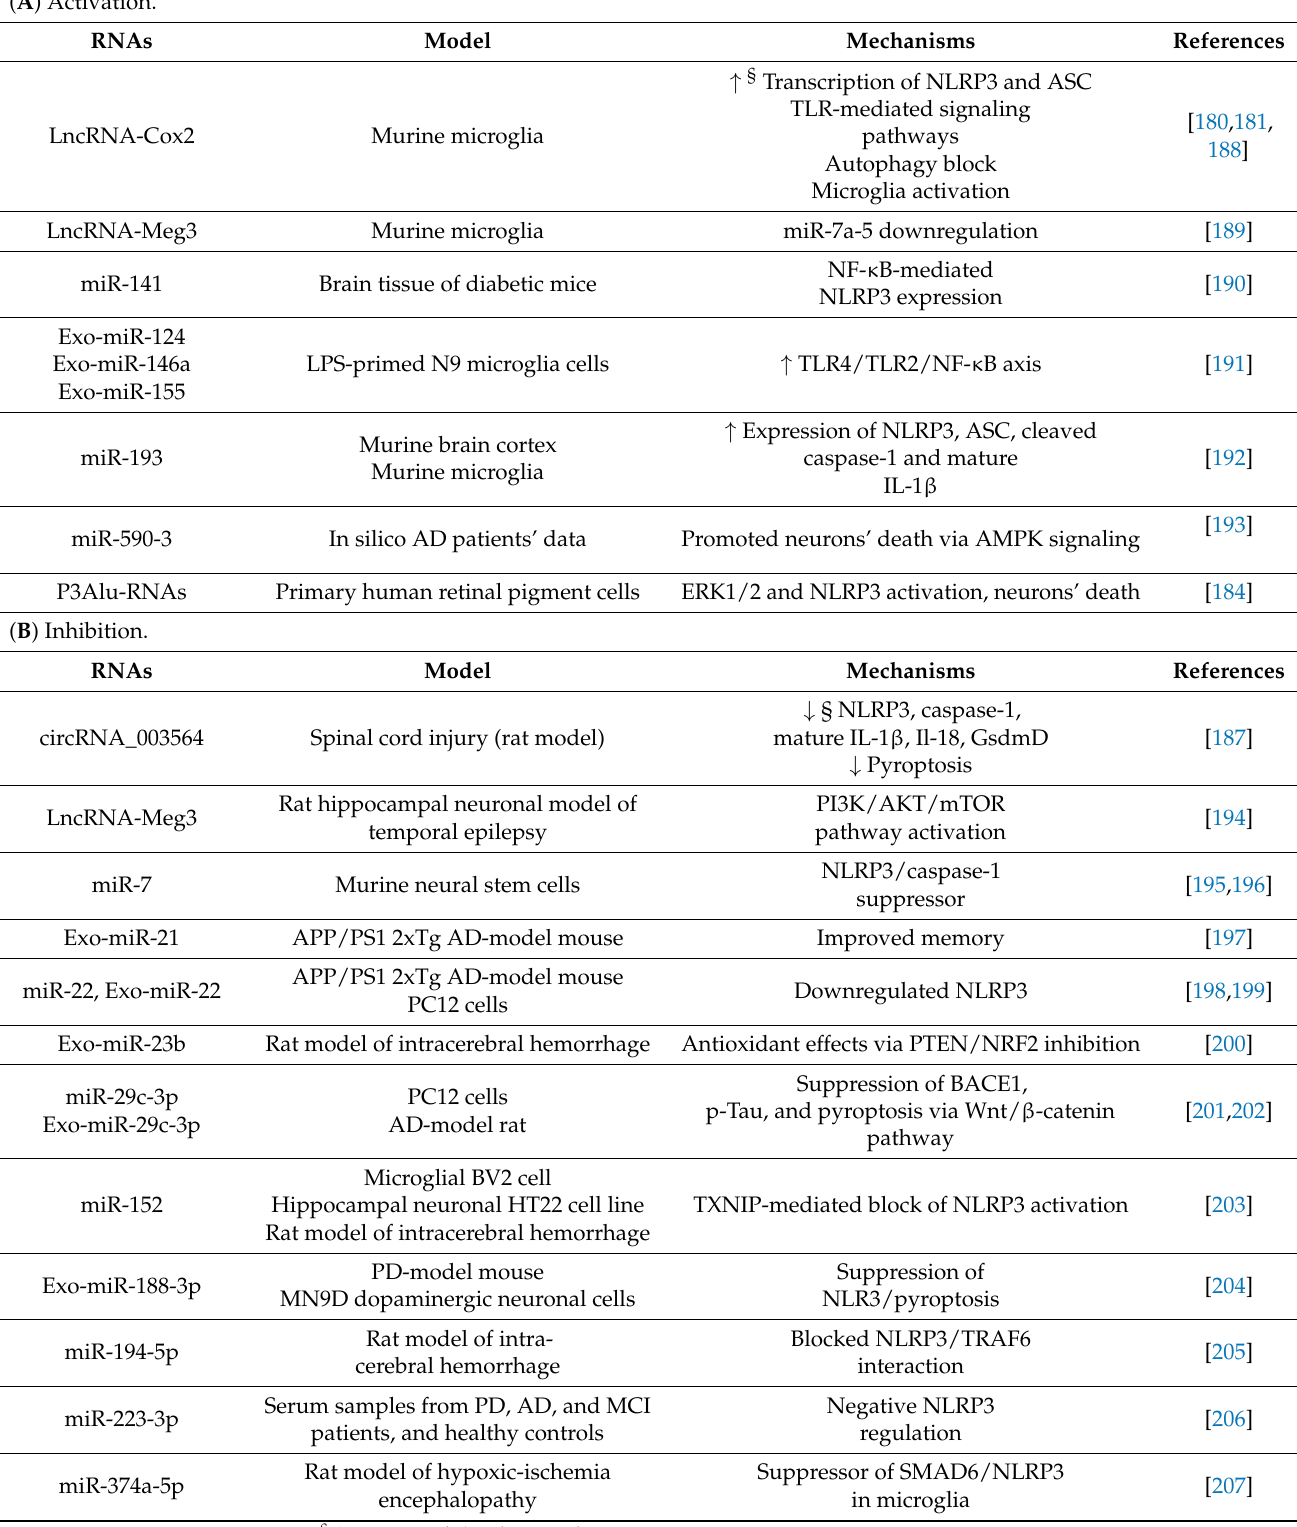
Table 2. RNAs modulating brain NLRP3 inflammasome’s